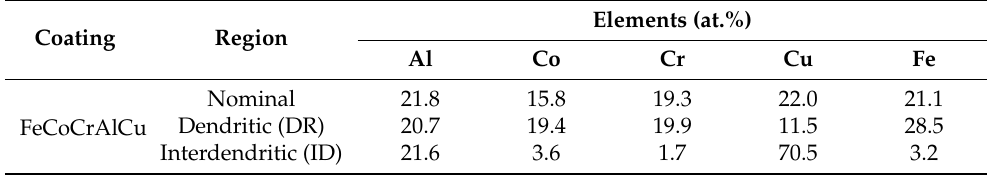
Elements (at.%) Al Co Cr Cu Fe